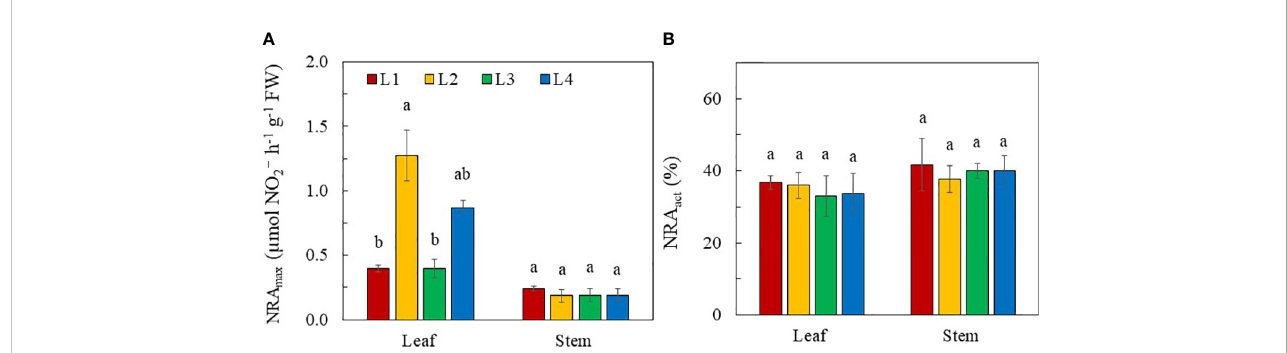
FIGURE 8 NRA max (A) and NR act (B) of purslane grown under different light conditions for 14 days. Values are means ± standard errors. Means with different letters are statistically different ( p <0.05; n =3) as determined by Tukey ’ s multiple comparison test for each plant organ. Refer to Figure 1 for the different conditions of L1, L2, L3 and